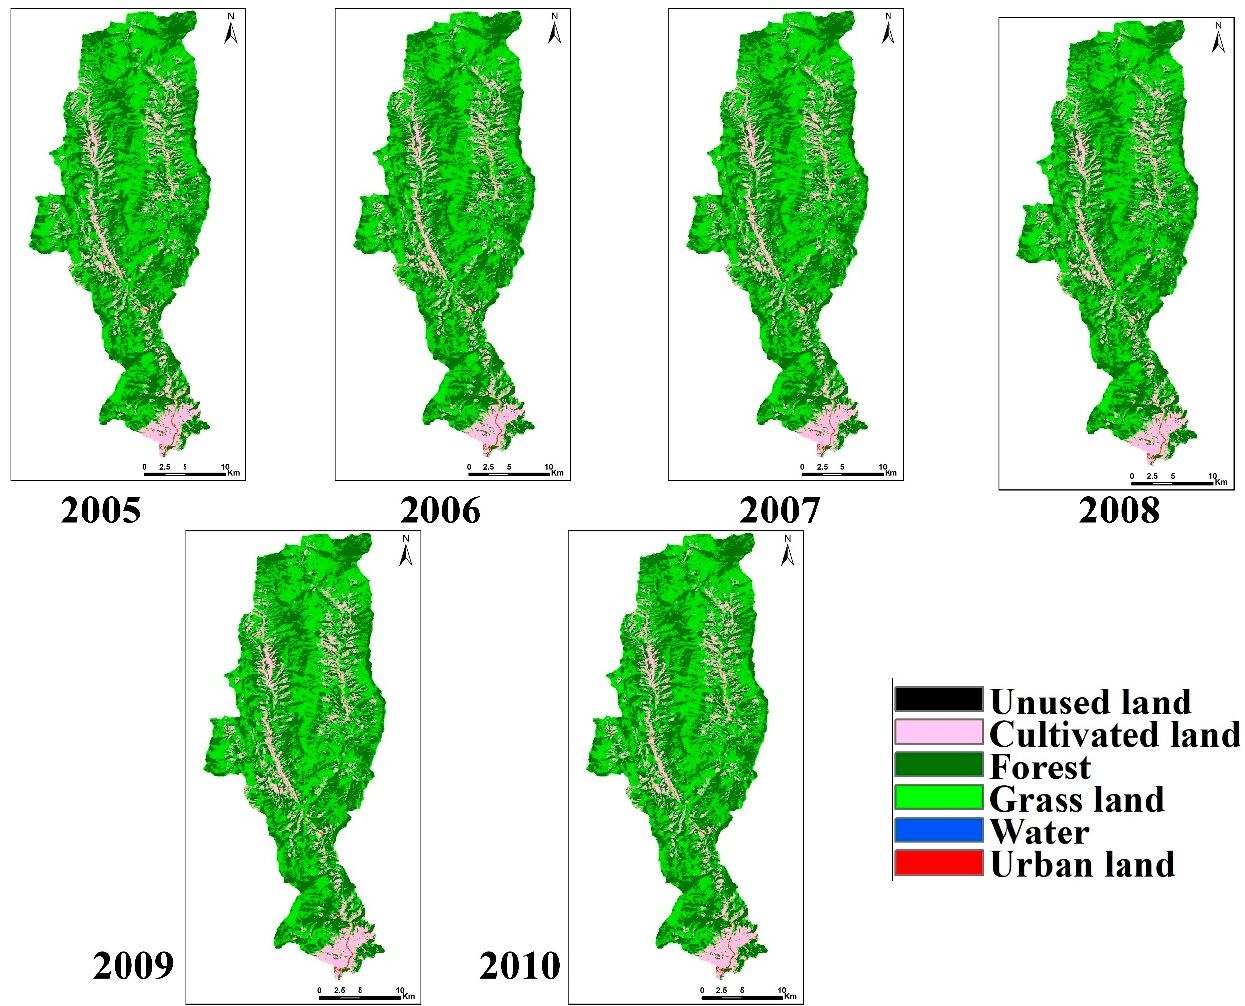
Figure 6. Land use maps of the study area.